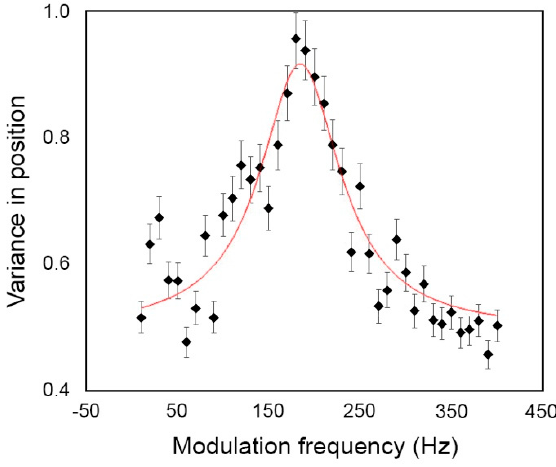
Figure 7. The variance measurement of the bead position as a function of laser modulation frequency.